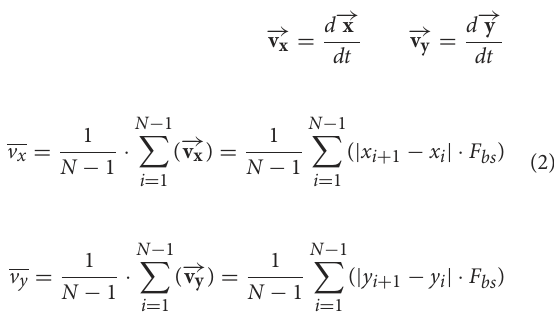
the whole power spectra into bins with each width of 0.05Hz. As explained in Formula 3, the normalized power spectrum was calculated in each of three frequency bands: 0 − 0.5Hz (Band 1, more associated with visual and vestibular systems (Band 3, more associated with proprioceptive system Gilfriche et al., 2018) in each sway direction to evaluate the power distribution. The power spectrum was normalized to the total signal power in each sway direction in each test condition in each participant.